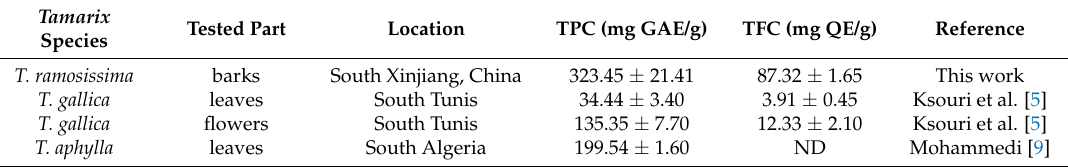
Table 1. Comparison of TPC and TFC with published data of Tamarix family.